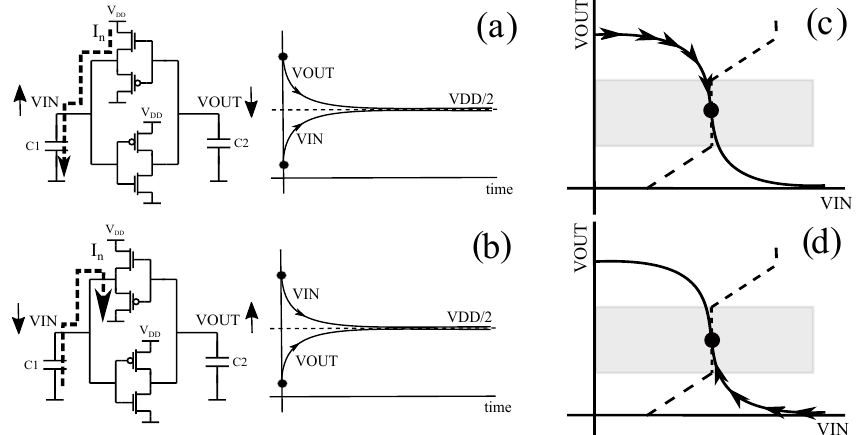
Figure 3. Time analysis and static analysis of the biasing working principle. ( a ) PFGA reaction to the initial conditions V IN = 0 V, V OUT = V DD . ( b ) PFGA reaction to the initial conditions